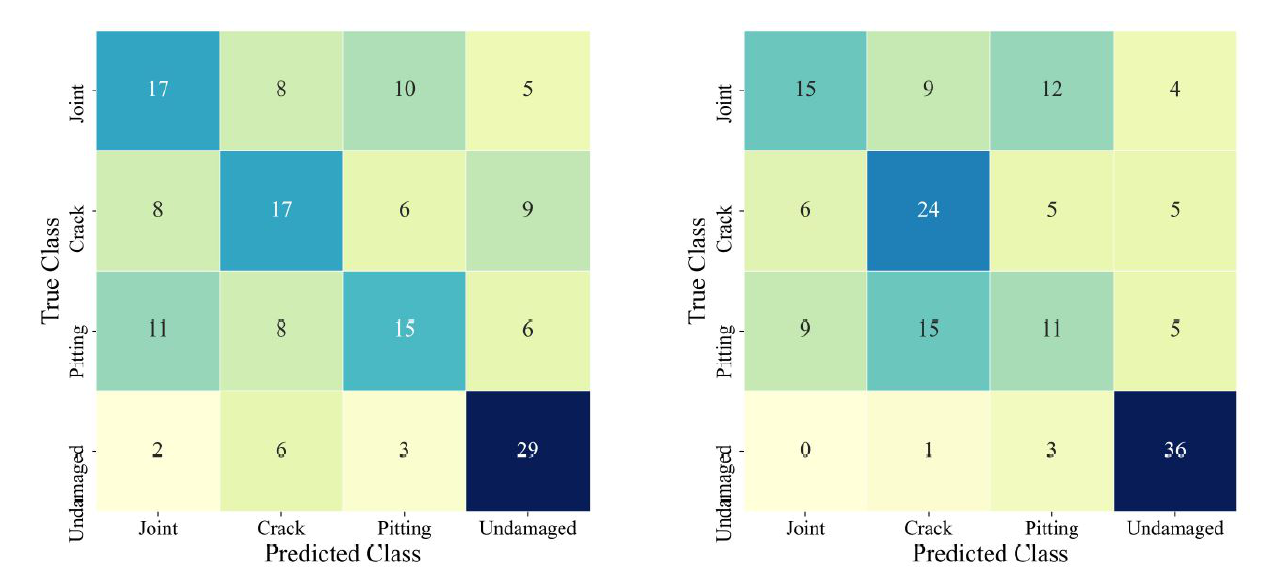
Figure 7. Confusion matrices for ( left ) validation dataset and ( right ) testing dataset for Scenario 1 using 100 real training